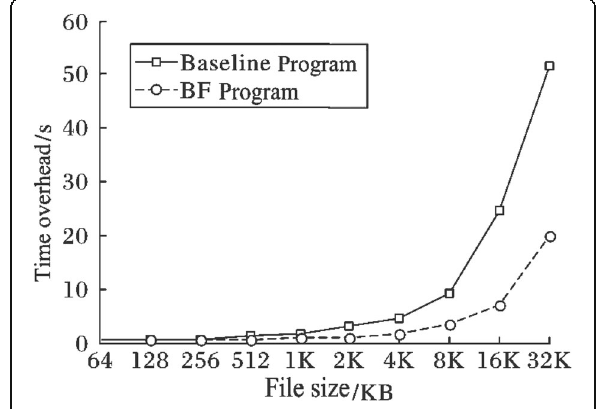
Fig. 6 Total time overhead for files without duplicates.